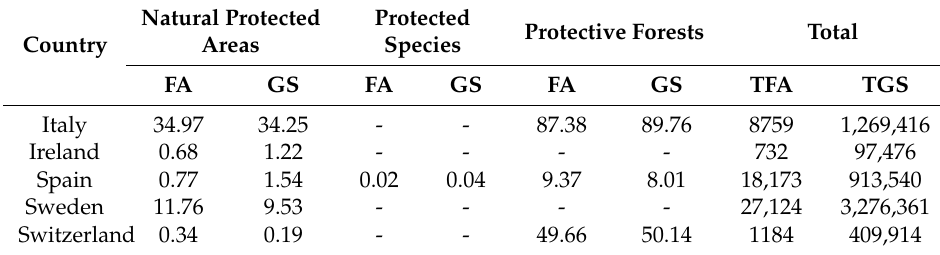
Table 2. Percentages affected by environmental and social restrictions of availability for wood supply, for the five European countries of the case study are given. Natural Protected Protected Protective Forests Country Areas Species